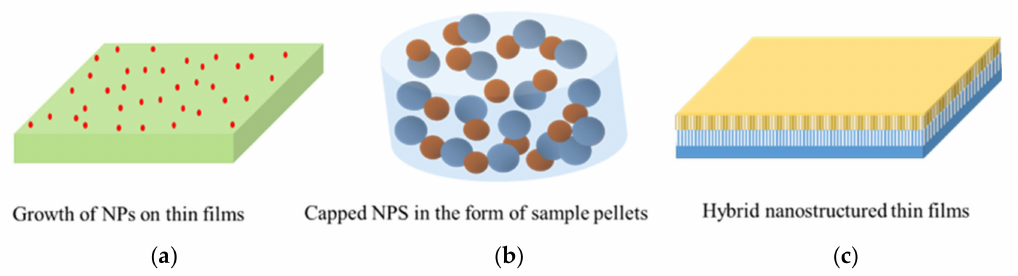
Figure 3. Schematic representation of different hybrid nanostructures. ( a ) Compose of NPs/thin films, ( b ) Hybrid NPs in the form of pellets and ( c ) Hybrid nanostructured thin films for the devel- opment of efficient thermoelectric devices.